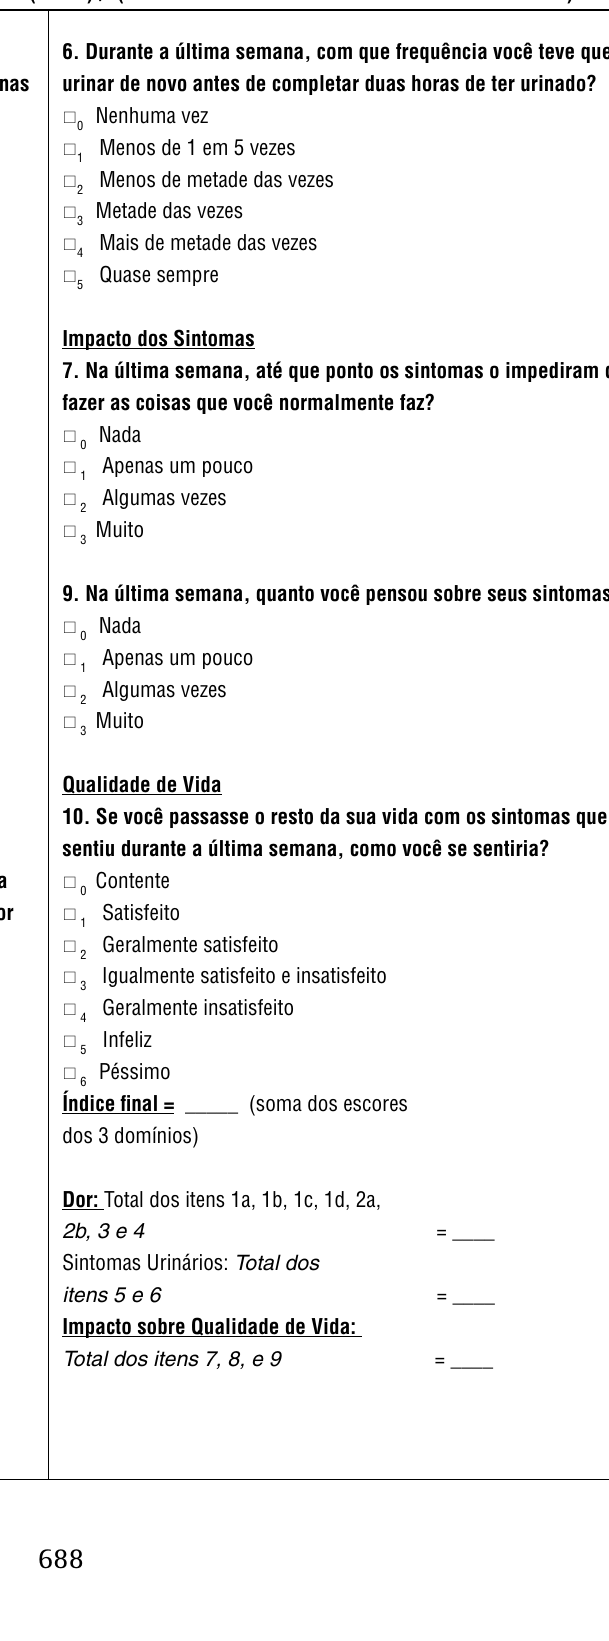
Figure 2 - Brazilian version of the National Institutes of Health Chronic Prostatits symptom Index, called NIH-CPsI